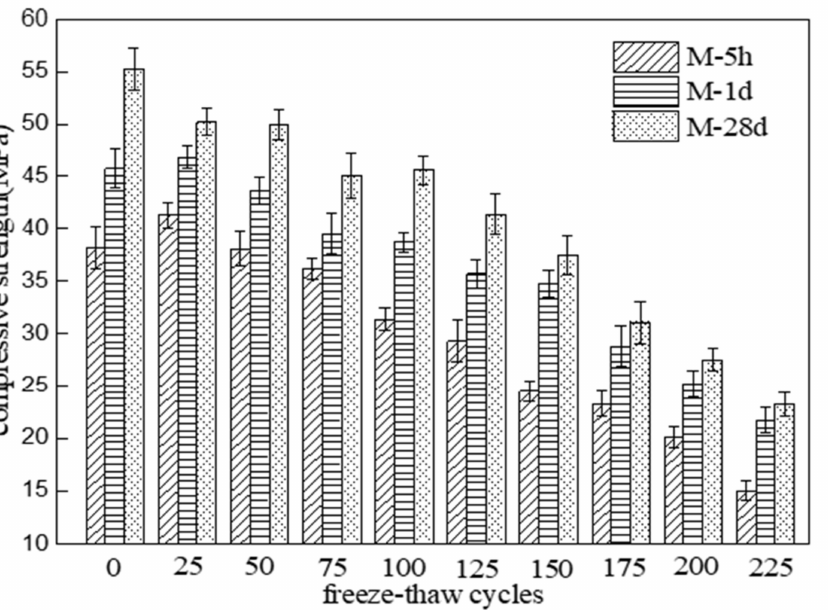
Figure 4. Compressive strength changes of MKPC mortar specimens with number of freeze–thaw cycles in 5% Na 2 SO 4